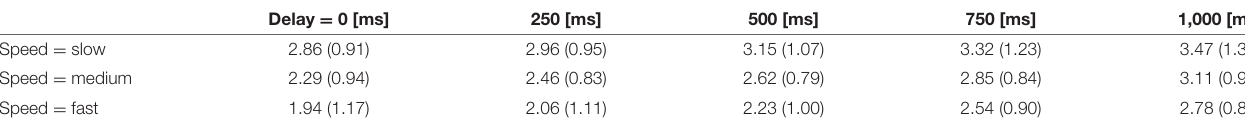
TABLE 3 | Average (standard deviation) of stiffness rating scores.